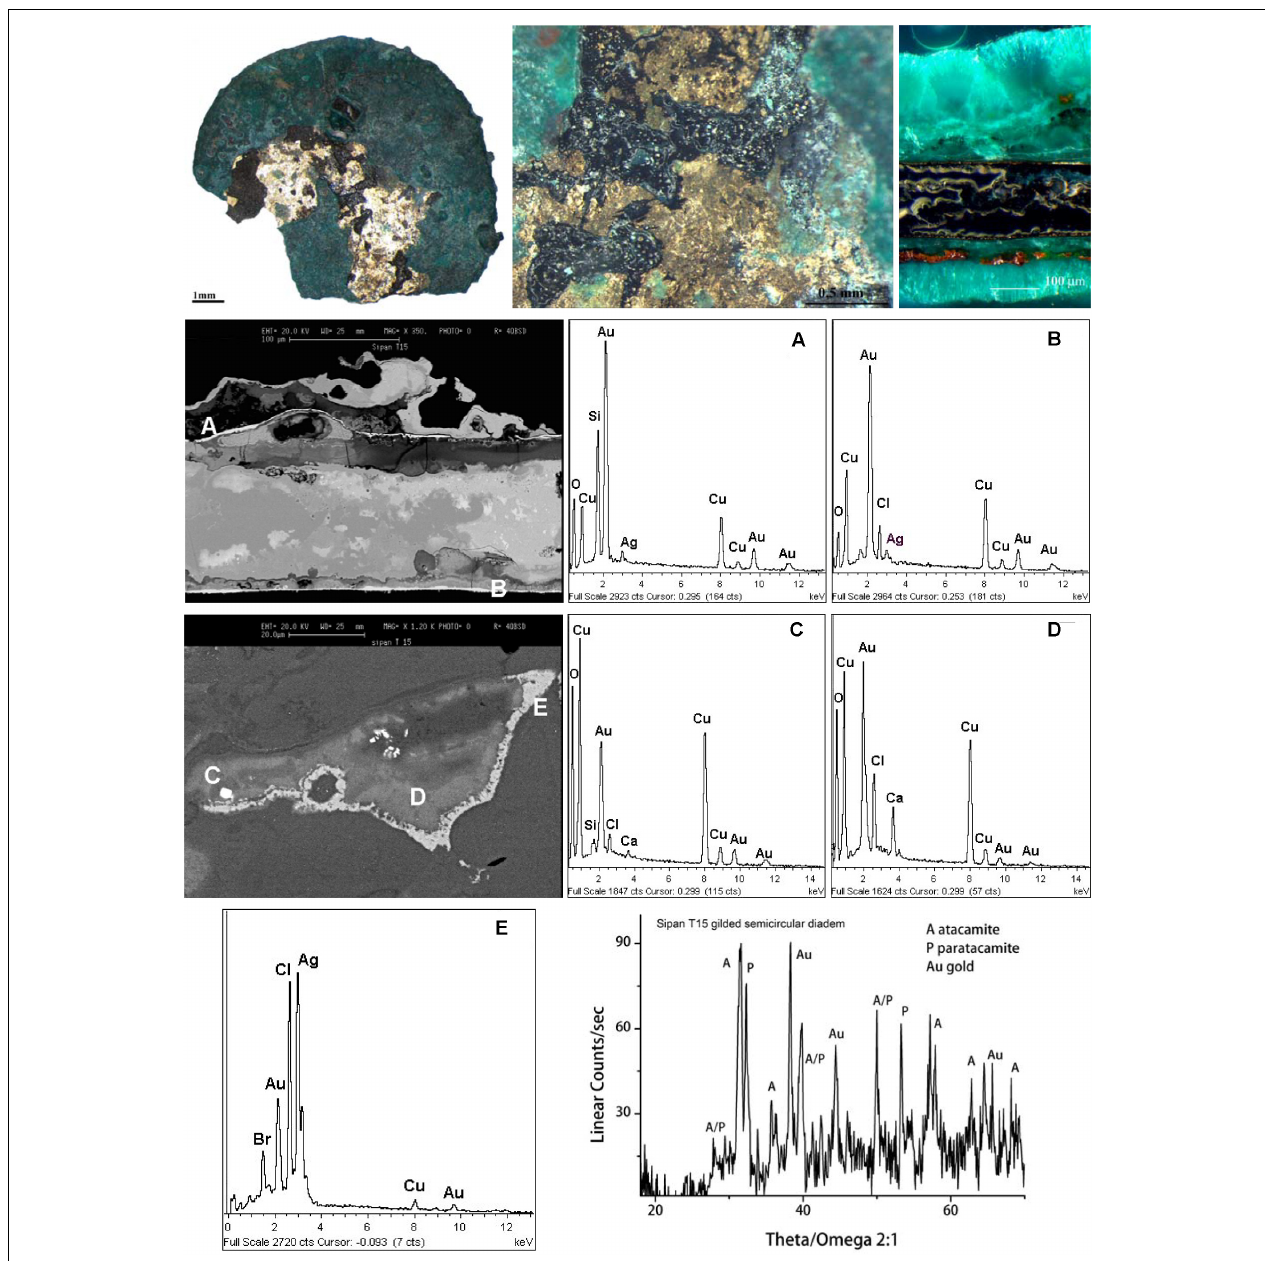
FIGURE 1 | SEM, EDS (spectrum A–E ), OM and XRD results describing the micro-chemical of a fragment of a gilded semicircular diadem (tomb T15 of a young warrior, Sipán). OM images and XRD pattern show the green patina composed of acicular atacamite [Cu 2 Cl(OH) 3 ] with areas of the bare original gilded surface. The OM image discloses also layered particles of reddish cuprite (Cu 2 O) and yellow-orange nantokite